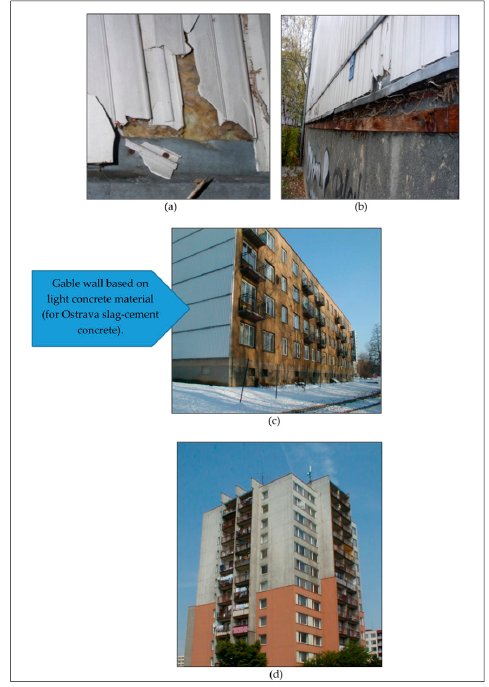
Figure 1. Renovation of prefabricated residential buildings in order to improve the moisture issues of external walls: ( a ) Degradation of load-bearing strips for anchoring the additional insulation grid and damage to the lamellas; ( b ) insufficient anchoring of insulating mineral wool; ( c ) example of post-thermally insulated external wall; ( d ) example of an additionally thermally insulated